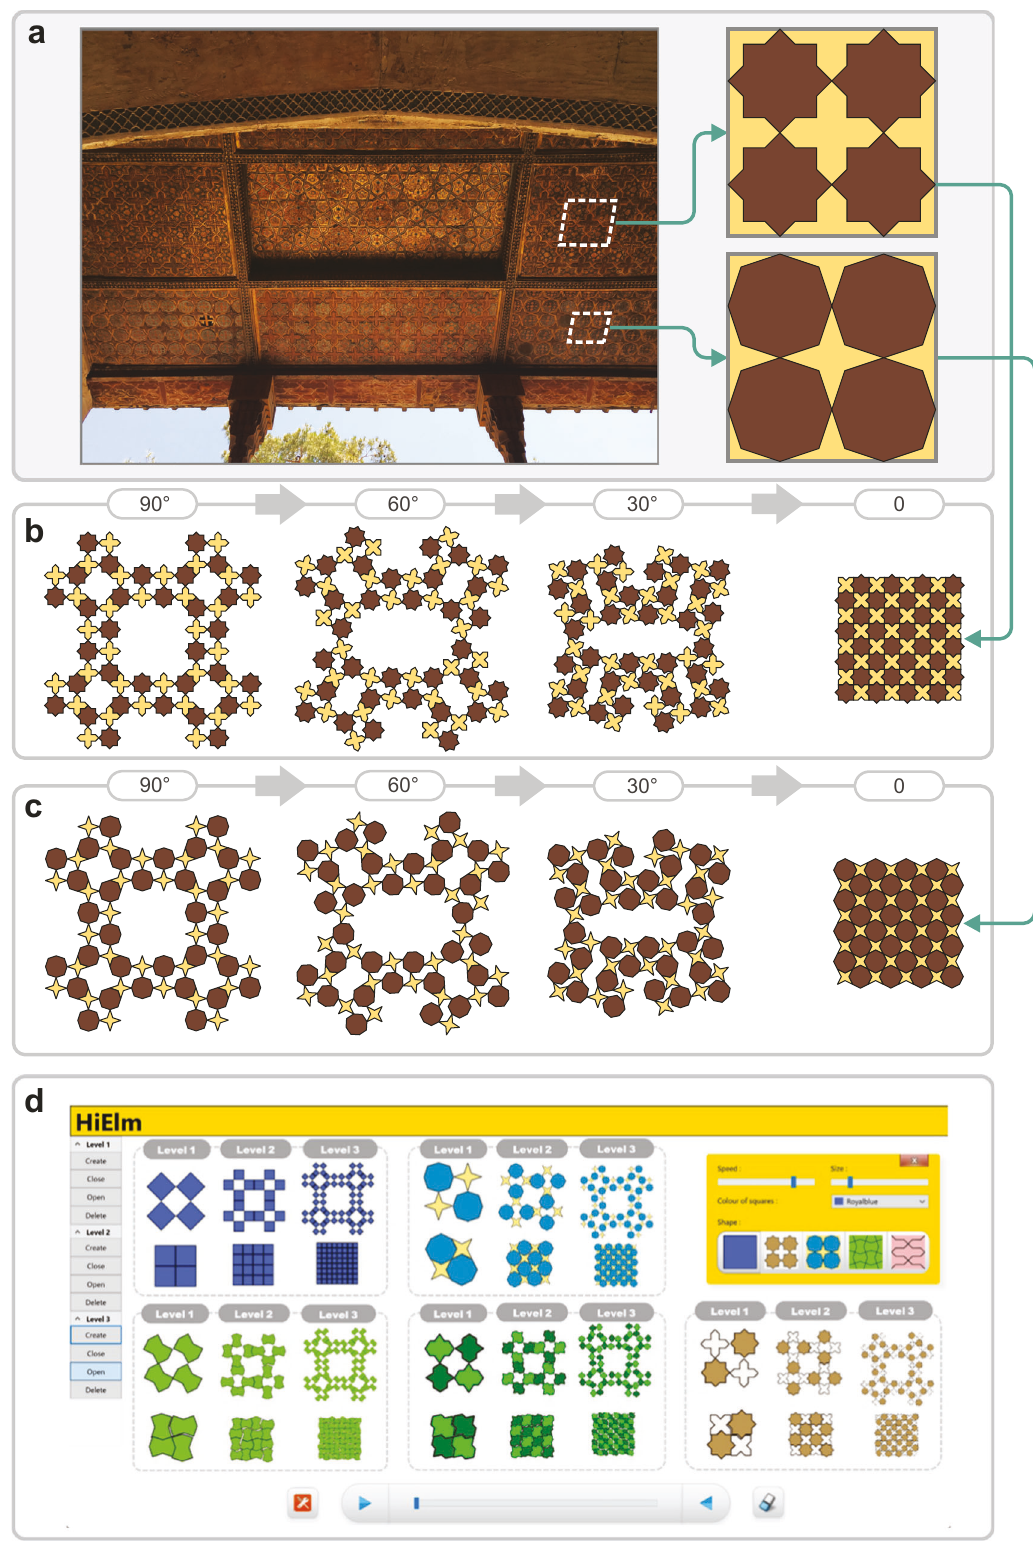
Fig. 6 Hierarchical ENAs inspired by Persian-Islamic geometrical patterns and the software HiElm. a The ceiling of the palace ‘ Hasht-Behesht ’ located in Isfahan, Iran, constructed in the seventeenth century 97 . Schematics of the deployment of level-3 ENAs in which square units are replaced by b ‘ Shamse ’ and c ‘ Setareh Chahar-Lenge ’ . d Graphical User Interface (GUI) of HiElm. In this application, in addition to square elements, four different Persian-Islamic motifs are provided which can be used to generate assemblies of up to level 3 of the